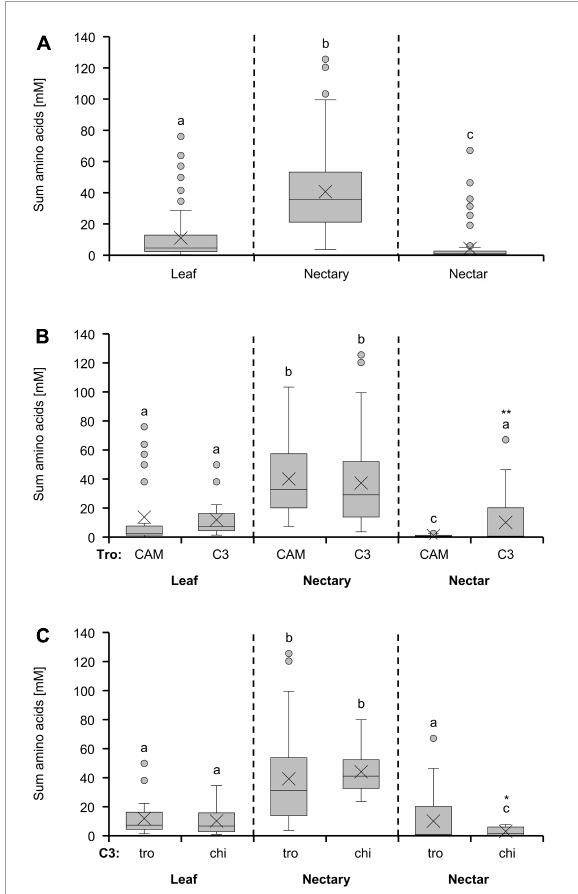
FIGURE2 Sum of 19 amino acids in leaf, nectary and nectar additionally depicted as boxplot diagram. The first diagram (A) shows data including all 36 bromeliad species ( n = 3). Additionally, the data were separated by photosynthesis type (B) and pollinator type (C) . The separation according to photosynthesis type includes 14 CAM and 22 C3 species. All CAM species have trochilophilous pollinators whereas the C3 species have either trochilophilous (tro) or chiropterophilous (chi) pollinators. Therefore, the C3 species were separated according to the pollinator type in 11 trochilophilous (tro) and 11 chiropterophilous (chi) species. Different letters represent significant differences in sum of amino acids between leaf, nectary and nectar (Tukey’s HSD; p < 0.05). The asterisks show different levels of significance between the photosynthesis and pollinator types, respectively (* p < 0.05, ** p <